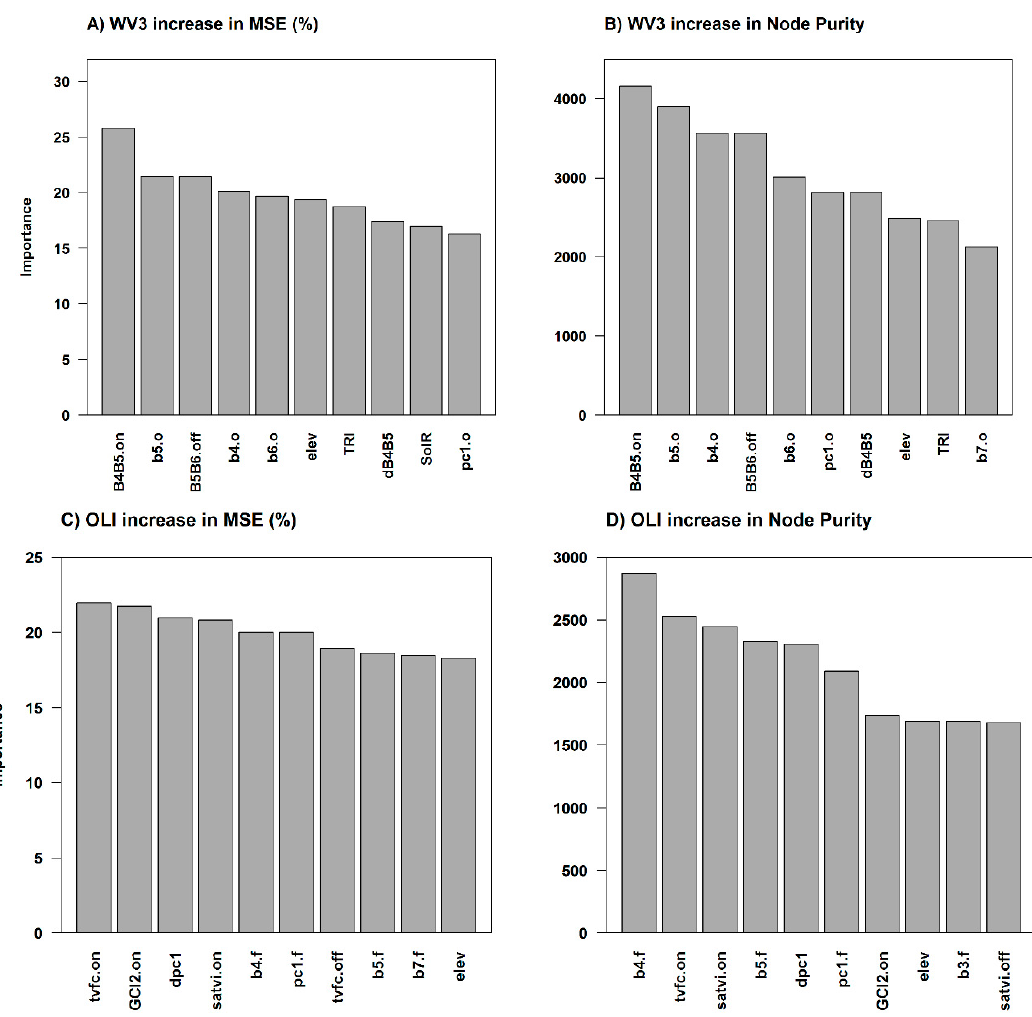
Figure 11. Variable importance plots for bare ground cover developed from ( A , B ) Worldview-3 and ( C , D ) Operational Land Imager top 10 satellite image bands, vegetation indices, terrain and vegetation cover variables.